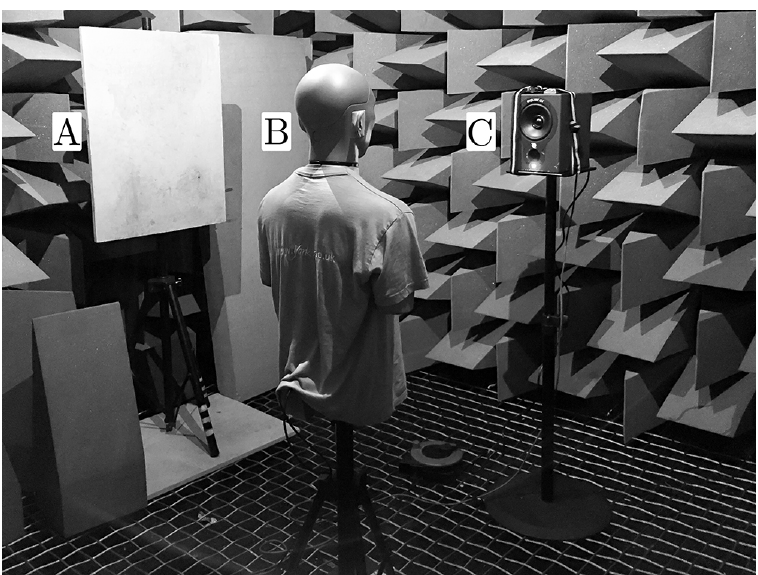
Figure 4. Measurement setup showing the reflective surface (A), KEMAR 45BC (B) and Equator D5 Coaxial Loudspeaker